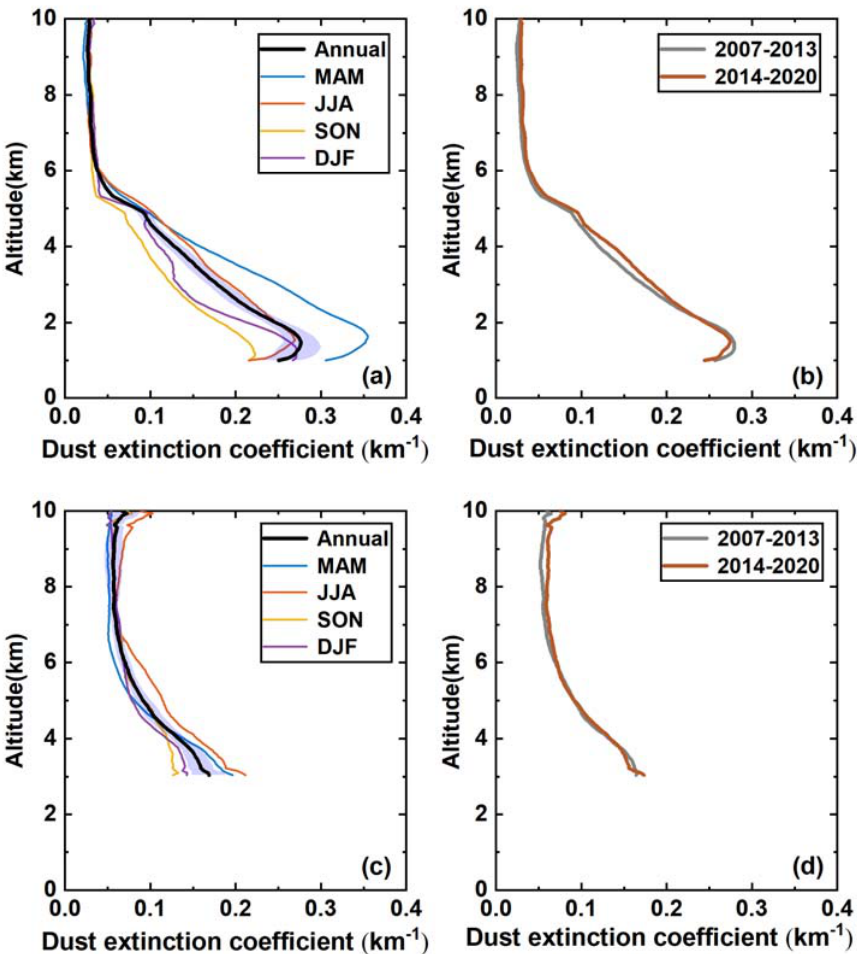
Figure 4. Seasonal and annual average profiles of dust extinction coefficient at 532 nm during 2007–2020 and the first and second 7 year averaged annual profiles over ( a , b ) TD and ( c , d ) TP. The shaded area represents the standard deviation of annual means.